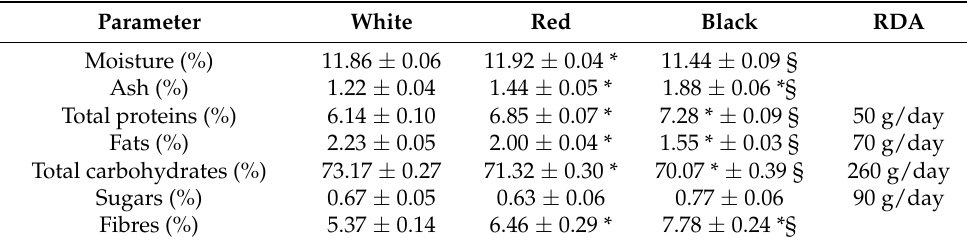
Table 2. Nutritional values of white, red, and black sorghum varieties. Abbreviation: Recommended Daily dose (RDA). Parameter White Red Black